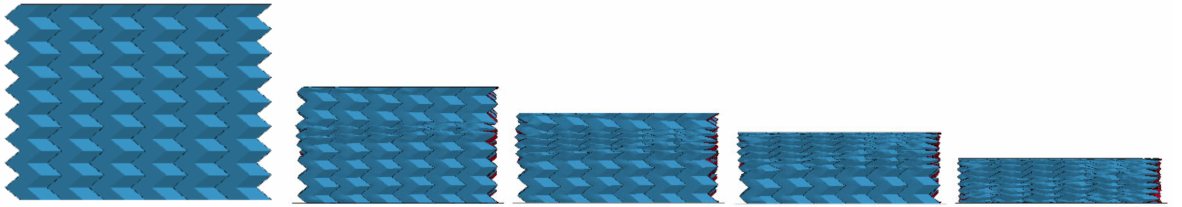
Figure 10. Out-of-plane crushing deformation of origami